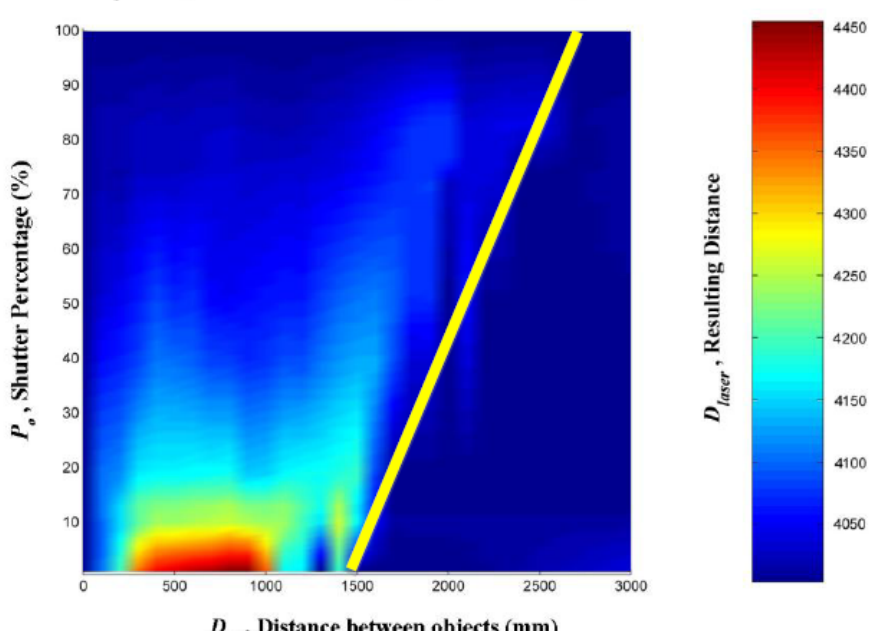
Figure 21. Graphic representation of the interpolated distance values (mm) for the case of D = 4,000 mm. The left-hand area delimited by the yellow line corresponds to the area of 1 influence of the second target hit by the laser